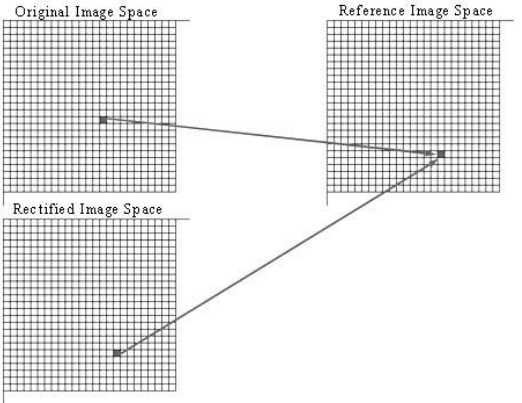
Figure 1. Quality assessment of geometric correction